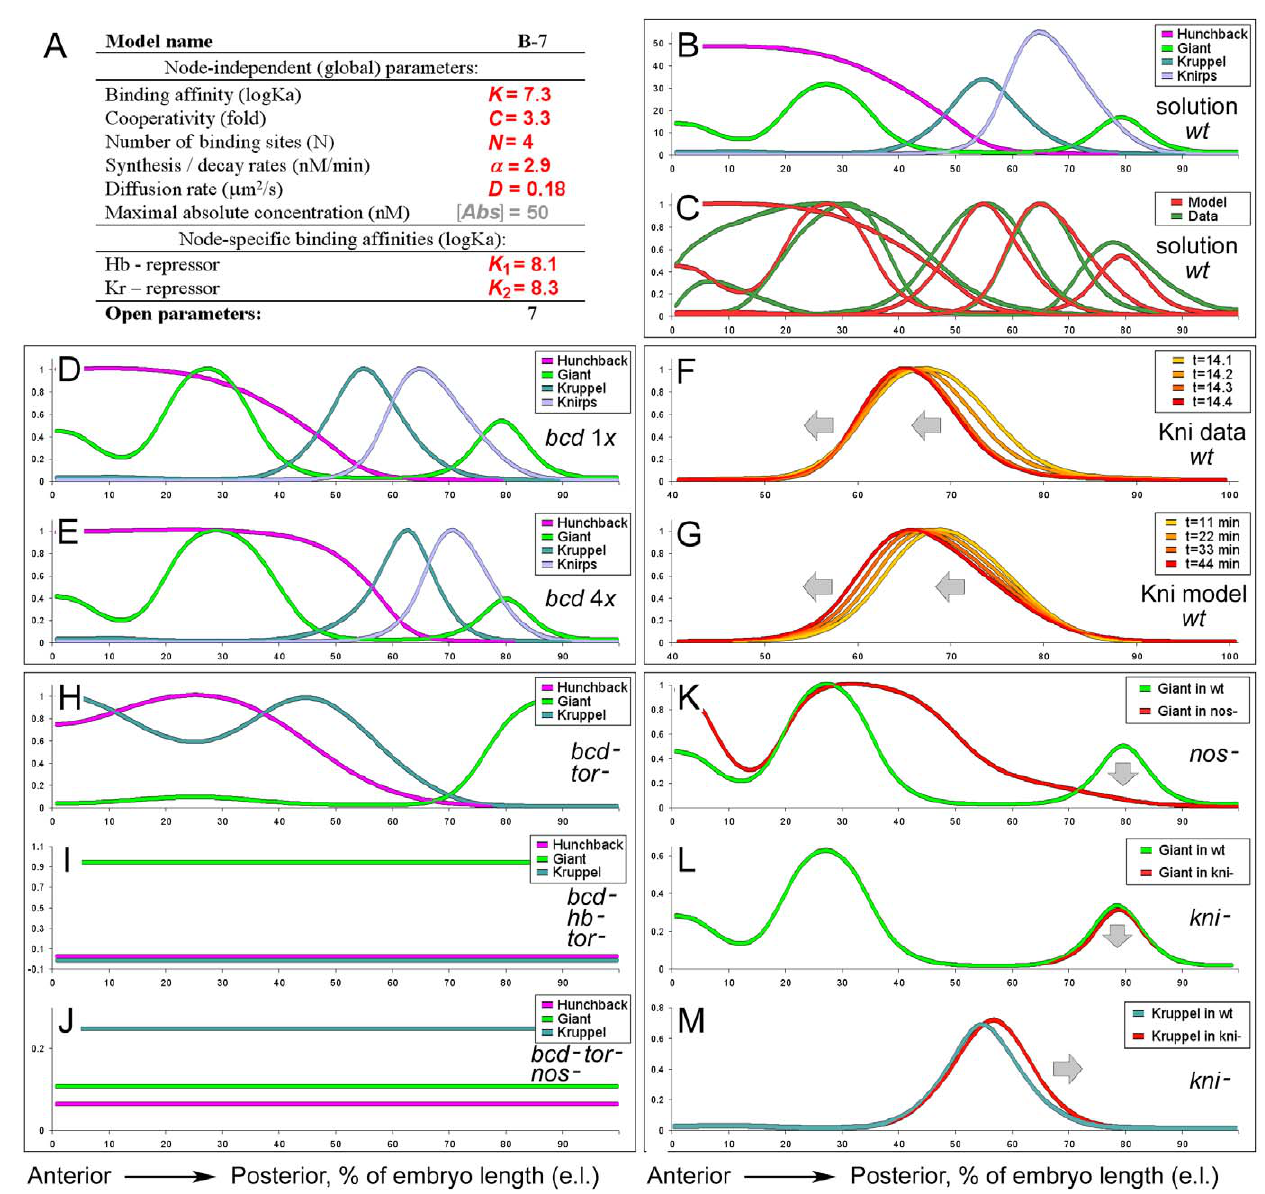
Figure 4. Reverse modeling features of the gap gene network. (A) Parameter values for the analyzed solution. (B) Absolute concentrations (nM) of gap gradients in the selected solution. (C) Data to model agreement (relative concentrations). (D, E) Posterior shift of gap stripes in response to 4x Bicoid. (F, G) Dynamic anterior shift of Knirps stripe. (H–J) Gap gradients in maternal mutants. (H) In the absence of Bcd, gt is expressed in the posterior and Kr in the anterior. (I) In the absence of both Bicoid and Hunchback, Gt has uniform pattern, while Kr is absent. (J) In the absence of Bicoid, the uniform Hunchback activates Kr uniformly; Giant is absent (Gt is low in this simulation). (K–M) Simulation of indirect regulatory links. (K) Uniform maternal Hunchback results in the loss of the posterior Gt stripe. (L) In a knirps mutant, the posterior Gt stripe is weakened. (M) Kr stripe in the knirps mutant is shifted posteriorly. Model contained no direct links for pairs Hb-Gt, Kni-Gt and Kni-Kr. doi:10.1371/journal.pone.0021145.g004 well ( Figure 4H–J ). Thus, for the bicoid null mutant in vivo ( bcd - , patterns ( Figure 4F, G ). Dynamics of more terminal Gt stripes tor - , to eliminate contribution of terminal system), Kruppel is was different, perhaps, due to the incomplete set of terminal inputs in the current model. Directly or indirectly, all gap genes are wired expressed in the anterior, while Giant is expressed in the posterior. to the major Drosophila morphogen Bicoid [21]. Increasing the The anterior expression of Kruppel in bcd - is explained by lower number of copies for bicoid gene in vivo shifts the entire array of gap concentrations of Hunchback, activating, but not repressing Kruppel . This Kruppel expression eliminates the anterior Giant and pair-rule stripes to posterior [10]. Simulation of 4 copies of bcd reproduced the expected shift for all four trunk gap genes (see expression (simulation in Figure 4H ). Removal of Hb from the bcd - , tor - embryos eliminates the anterior Kruppel expression, so Figure 4D, E ). Mutants for maternal determinants, Bicoid and Hunchback disrupt expression of gap genes [22]; major features of the Giant is expressed both in the anterior and the posterior these mutant phenotypes have been reproduced by the model as regions (simulation in Figure 4I ). Hb exhibits uniform expression